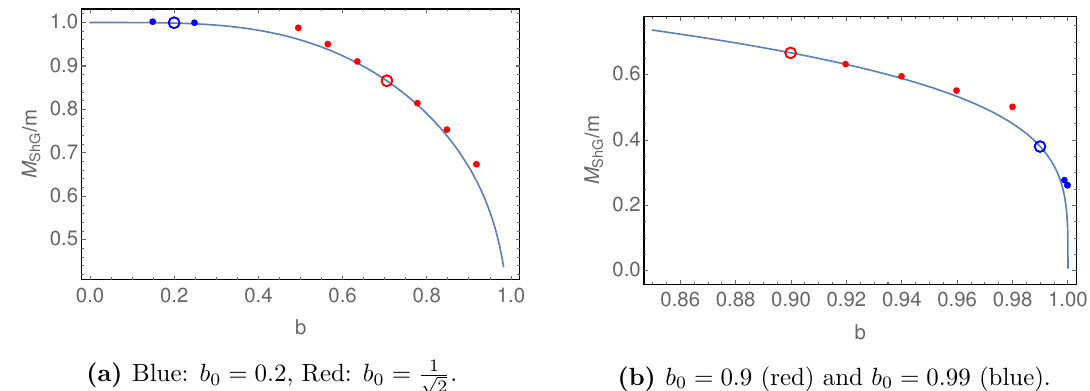
at four different values of b 0